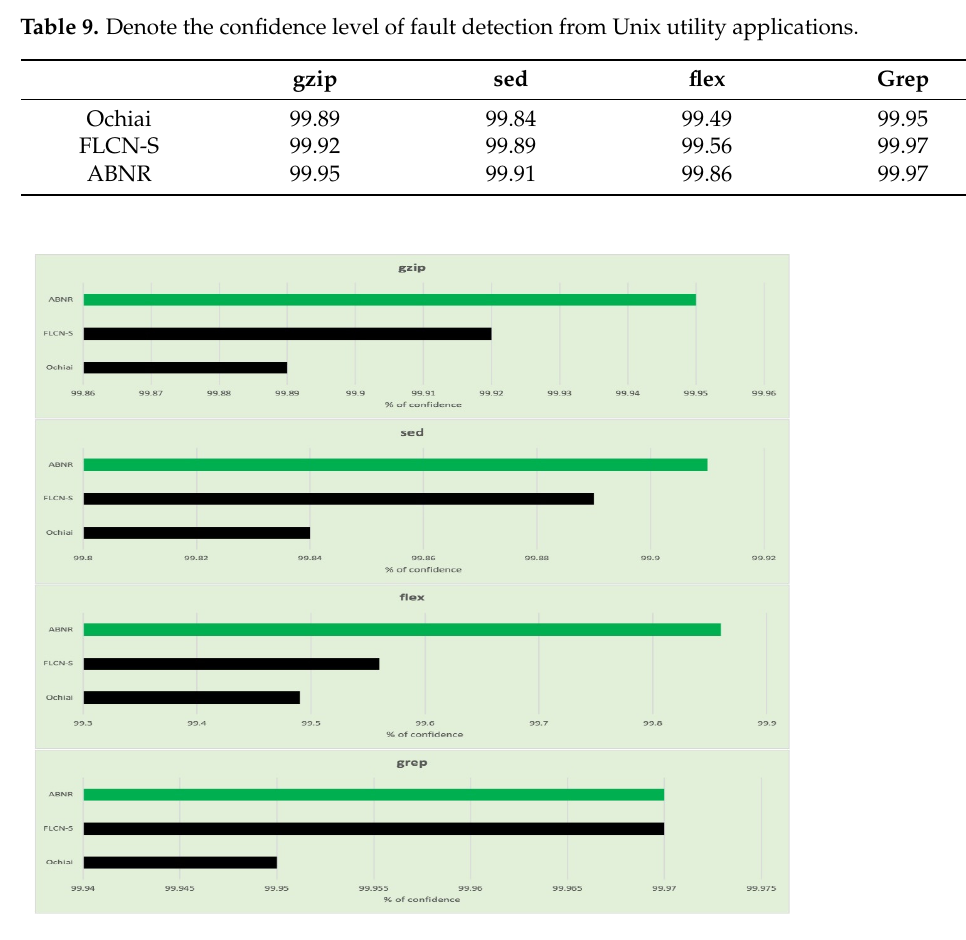
Figure 8. Graphs representing the confidence level of fault localized for each category in Unix utility applications.